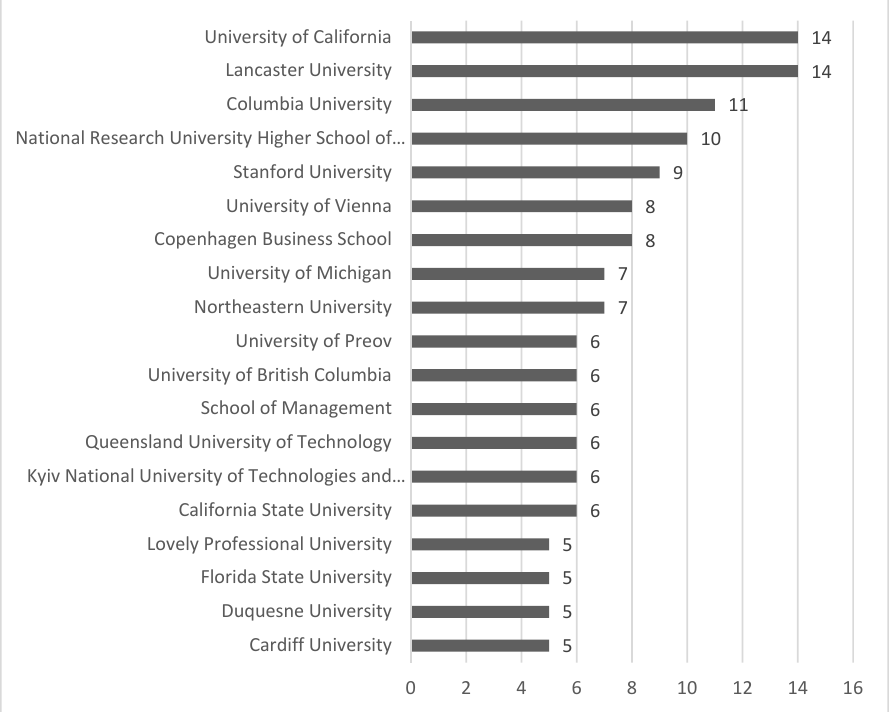
Figure 7. Visual Map of Prominent Institution’s Collaboration on EVA Research.